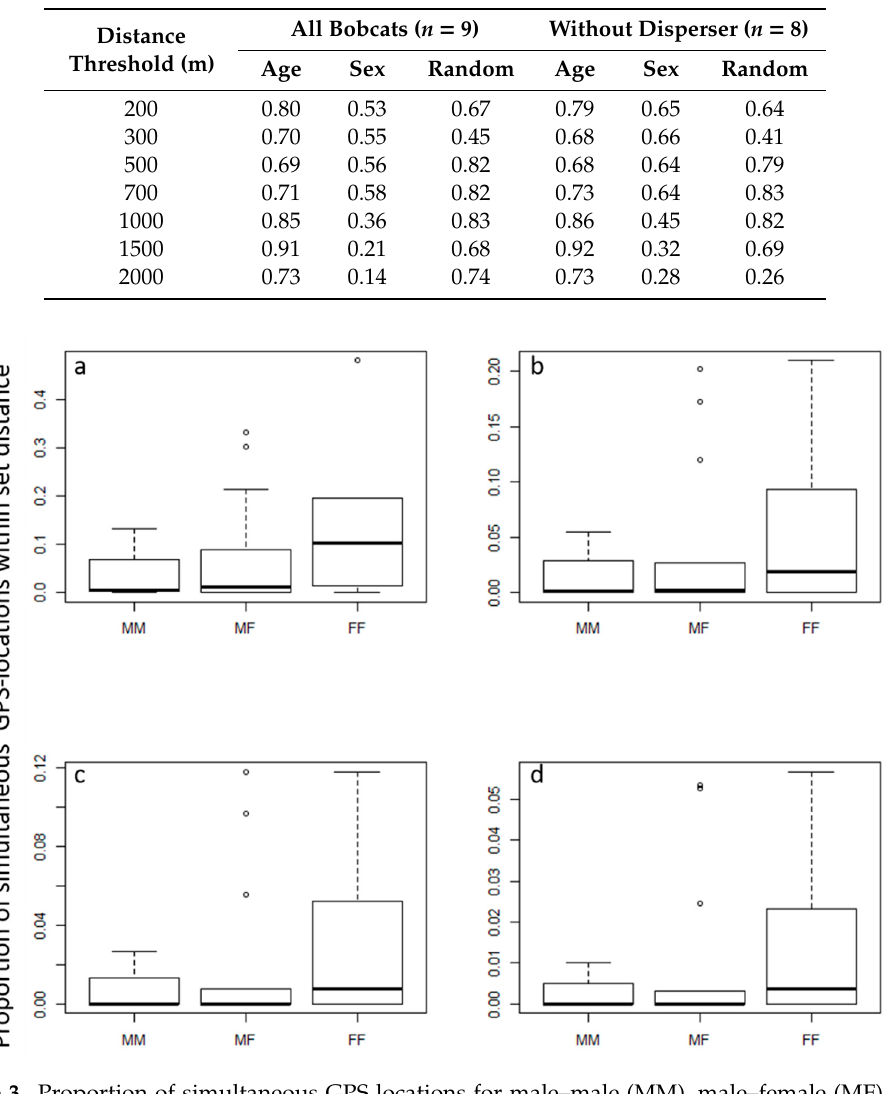
Figure 3. Proportion of simultaneous GPS locations for male–male (MM), male–female (MF), and female–female (FF) bobcats that were simultaneously within ( a ) 1000, ( b ) 700, ( c ) 500, or ( d ) 300 m of one another.